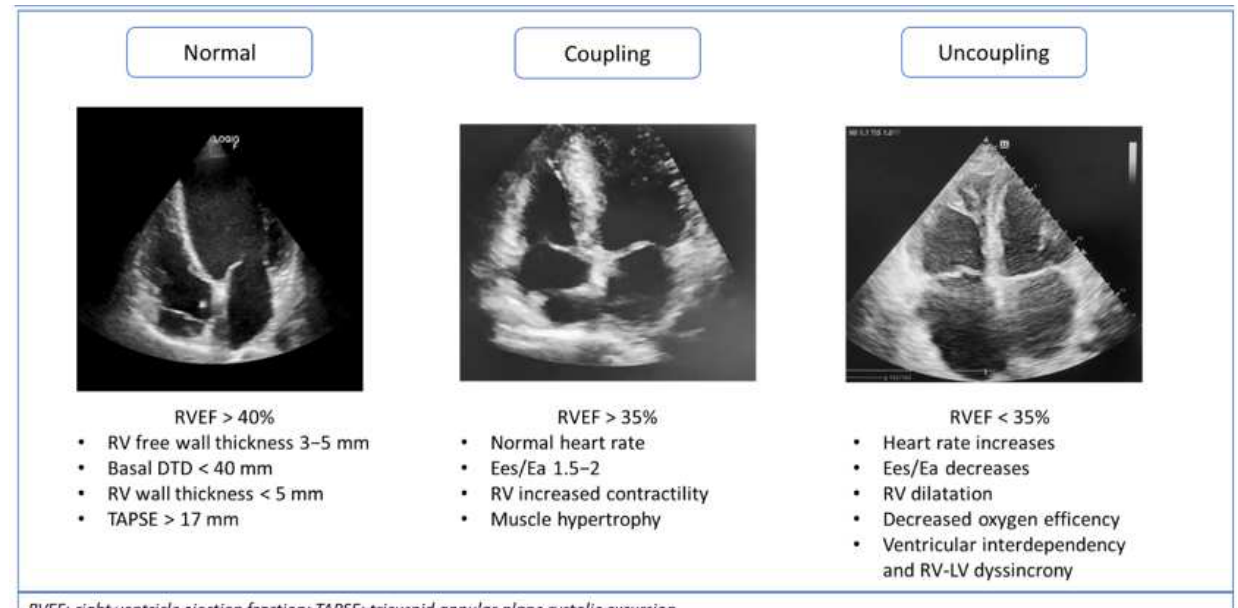
Figure 2. Mechanisms of RV adaptation in pulmonary hypertension (PH) progression related to heart failure with preserved ejection fraction (HFpEF): ventriculo-arterial coupling and uncoupling.